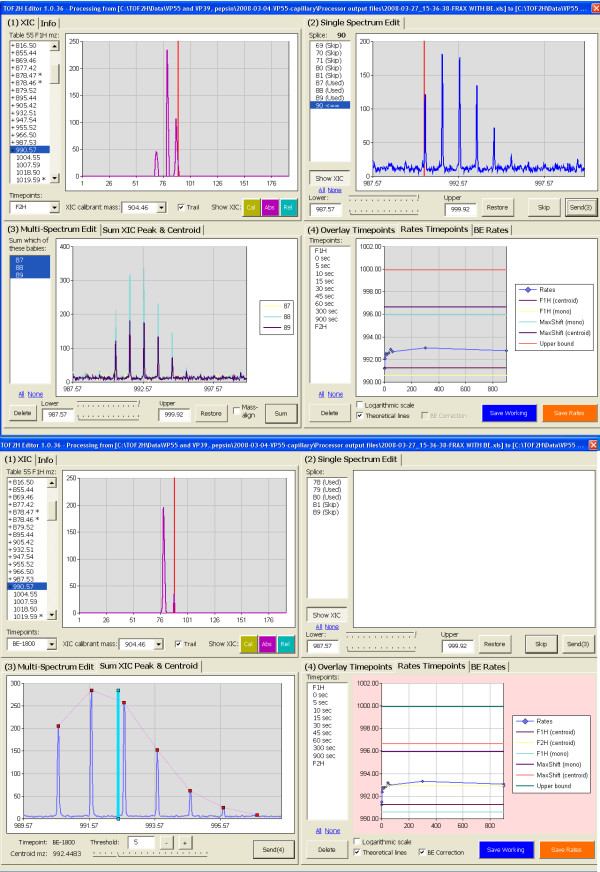
Screen captures of TOF2H-Editor GUI. In each of the two screen captures shown, upper left, upper right, lower left, lower right quadrants (Q1, Q2, Q3, Q4, respectively) are as described in the text. In the peptide listing (upper left), already-processed entries are prefaced with a "+"). For the XIC displayed (Q1), active XIC fractions populate the listing in Q2, and the spectral segment for the first is plotted (from 3 Da below F1H monoisotopic mass to either "upper bound" or the highest mass isotope detected). In Q2, spectral segments can be sequentially rejected or sent to Q3 (after re-endpointing if desired, though upon sending to Q3, overlaid segment lower endpoints default to 0.5 Da below the monoisotopic mass). In win(3), segments can be mass-aligned (via a small offset to slight mass errors), then averaged, leading to the view in the lower panel in which spectral peaks are detected then the weighted mean (centroid) mass calculated. Sending the centroid mass to Q4 adds a point to the growing rate plot (shown with overlaid theoretical lines). In addition, the averaged raw spectral segment is sent to another tab of Q4 (not shown). Q4-upper, lower: Before and after BE correction, respectively.